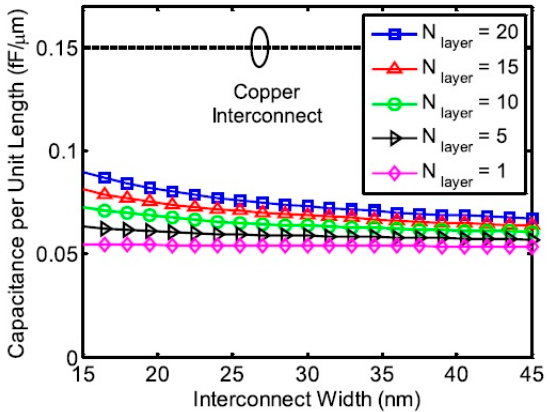
Figure 16. Capacitance per unit length of graphene sheet consisting of different numbers of graphene layer as a function of width [76]. Reproduced with permission from [76]. IEEE, 2015.